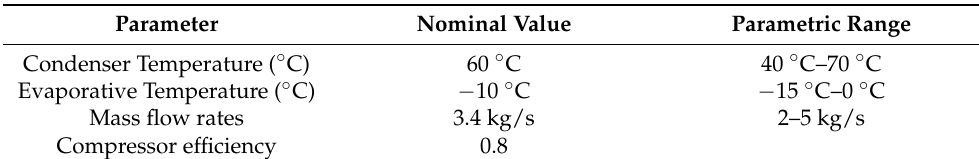
Table 6. Operating Conditions were employed in this study.